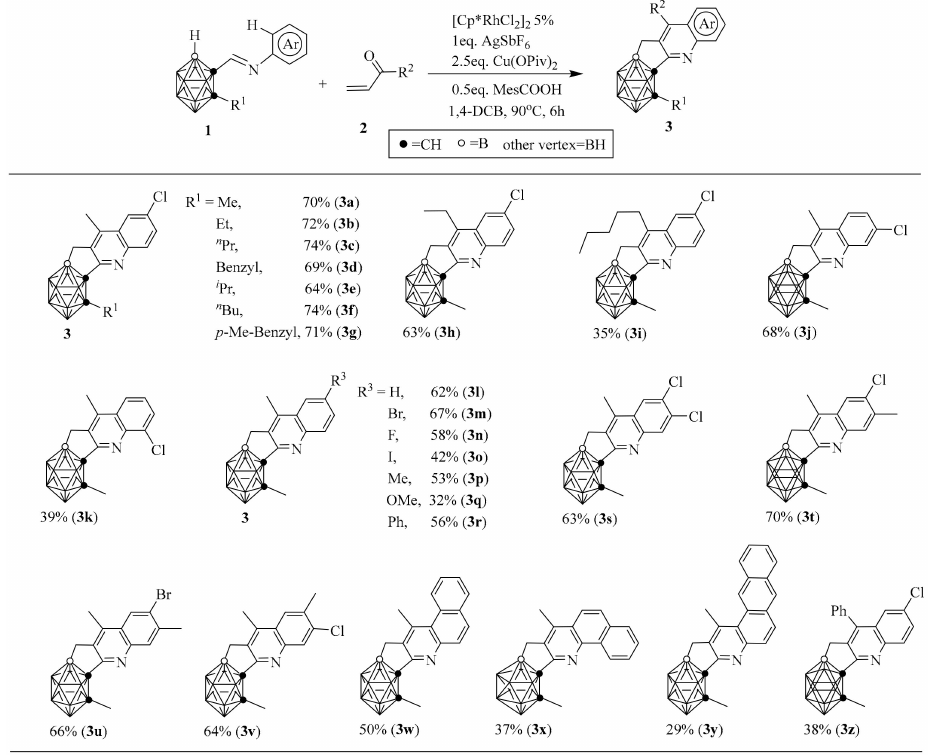
Figure 1. Synthesis of o -carborane-fused cyclopenta[ b